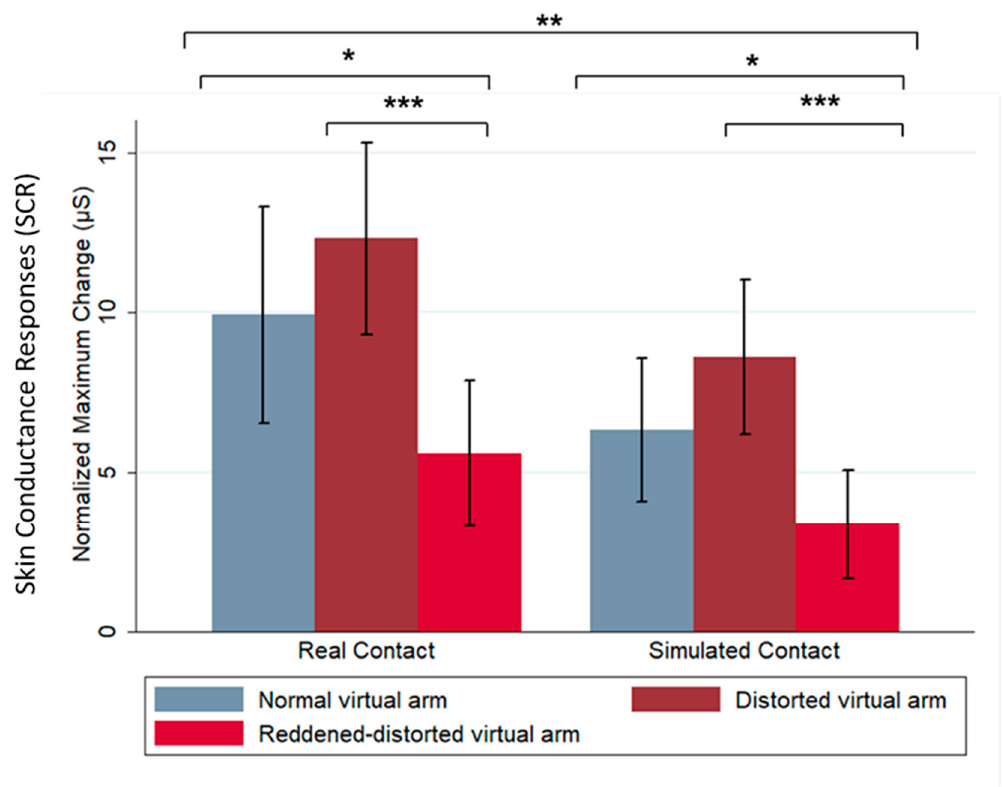
Figure 2. Skin conductance response (SCR) increased when the virtual needle contacted (real contact) the virtual hand in all three virtual arm conditions, while the reddened-distorted virtual arm showed a comparatively decreased SCR in both real and simulated contact of the threatening stimulus. Difference in SCR after the threatening stimulus contacted (real contact) or approached (simulated contact) the virtual hand in all three virtual arm conditions. Bars show mean change in SCR and error bars indicate 95% confidence interval. * p < 0.05, ** p < 0.01, *** p < 0.001.